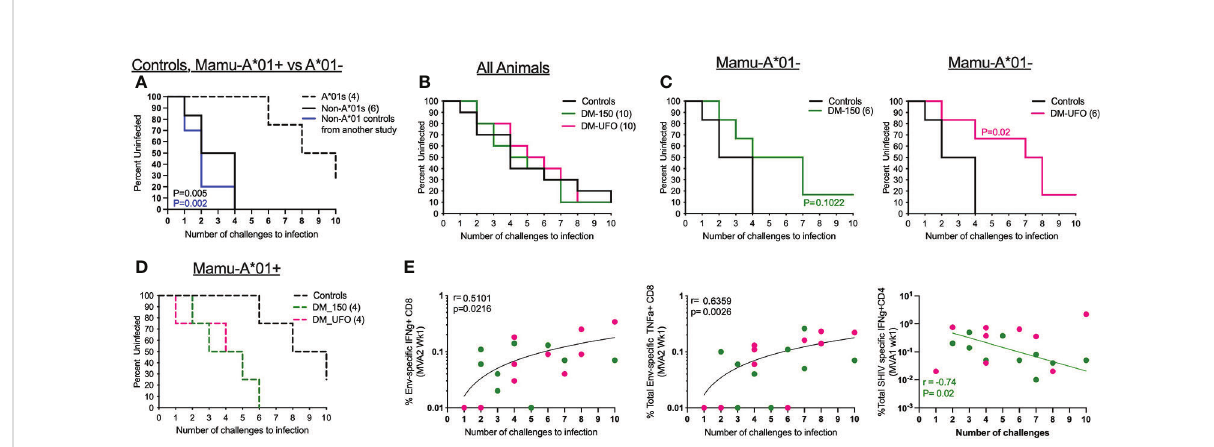
FIGURE 6 DM-UFO signi fi cantly delays acquisition of SHIV1157ipd3N4 in Mamu-A*01- RMs. (A) Kaplan-Meier plot depicting the number of challenges required to infect control RMs divided by Mamu-A*01 status in control animals. (B) Kaplan-Meier plot depicting the number of challenges required to infect all animals, including vaccinate and unvaccinated Mamu-A*01 and Mamu-A*01- RMs. (C) Kaplan-Meier plot depicting the number of challenges required to infect vaccinated and unvaccinated Mamu-A*01- RMs. (D) Kaplan-Meier plot depicting the number of challenges required to infect vaccinated and unvaccinated Mamu-A*01+ RMs. (E) Correlation between the number of challenges to infection and the total Env speci fi c IFN g + CD8 T cell, total Env speci fi c TNF a + CD8 T cell, and total SHIV speci fi c IFN g + CD4 T cell responses post MVA2 and